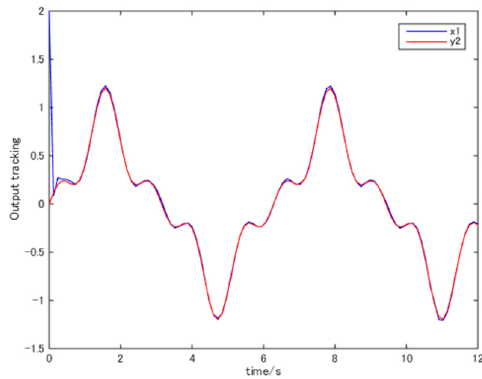
Figure 1. The trajectories of x 1 ( t ) and y r ( t ) .